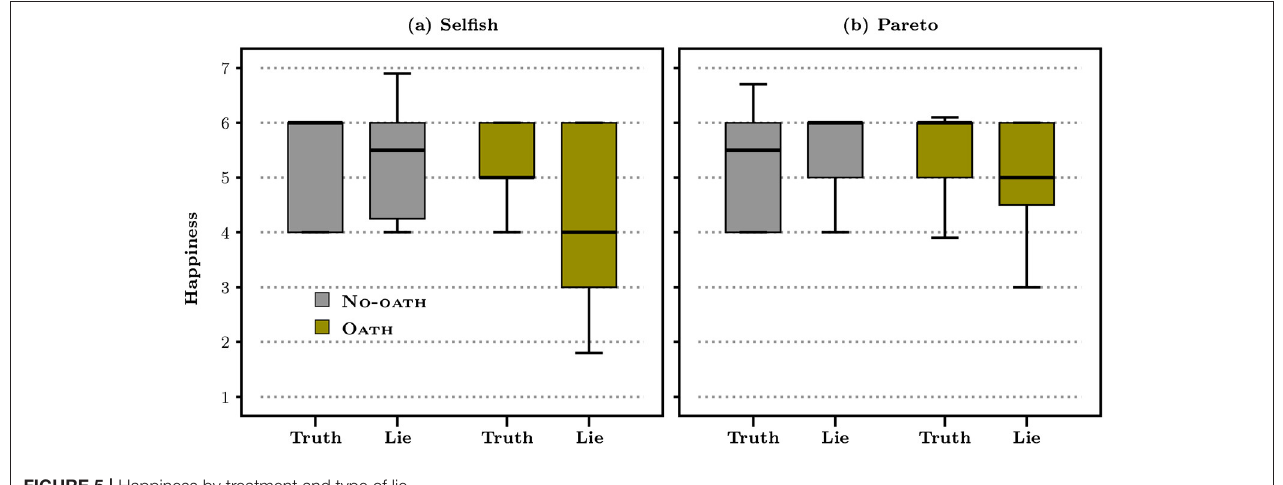
FIGURE 5 | Happiness by treatment and type of